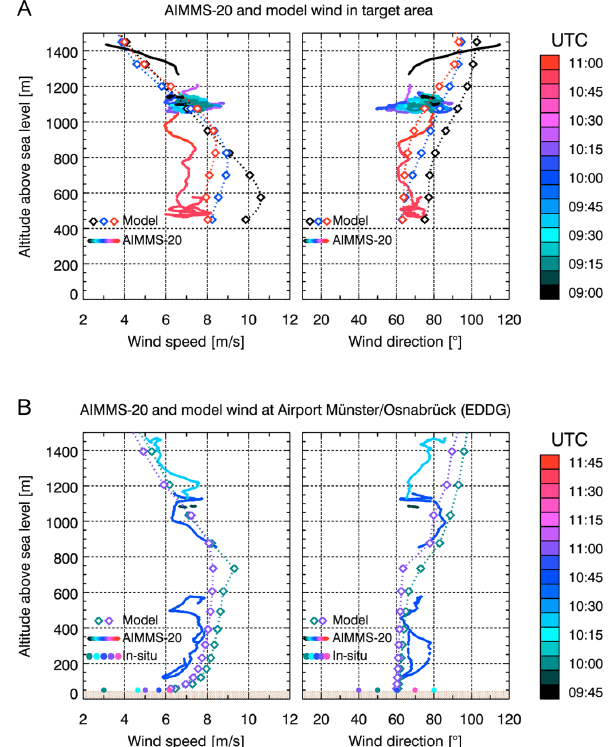
Fig. 8. Panel (A) : comparison between mean model data (diamonds) for times 09:00, 10:00 and 11:00UTC and AIMMS-20 turbulence probe wind data (thick line). The colour indicates the time accord- ing to the colour bar to the right. The left plot shows wind speed, the right plot wind direction. Panel (B) : AIMMS-20 wind data from a descent–ascent profile at the airport M¨unster/Osnabr¨uck and the surrounding area compared with model data at a grid point less than 100m away from the airport (52.1279 ◦ N, 7.6800 ◦ E). Additionally, in situ data from the weather station (EDDG) are shown. Times of measurements are according to the colour bar on the right. In situ data from the weather station at the airport M¨unster/Osnabr¨uck (EDDG) have been obtained from Weather Underground (http: //www.wunderground.com/, last access: May